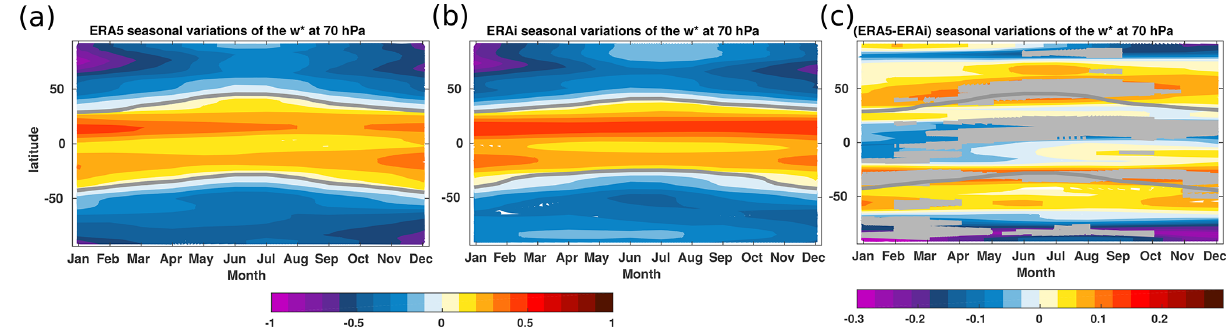
Figure 3. Monthly and latitudinal variations of monthly mean w ∗ (in mms − 1 ) at 70hPa from the ERA5 reanalysis (a) , the ERA-Interim reanalysis (b) , and the difference between the ERA5 and the ERA-Interim reanalyses (c) for the 1979–2018 period. Grey horizontal lines indicate the zero w ∗ contours. Grey shading in panel (c) indicates regions where the differences between the ERA5 and ERA-Interim reanalyses are statistically significant at 95% confident level estimated using Student’s t